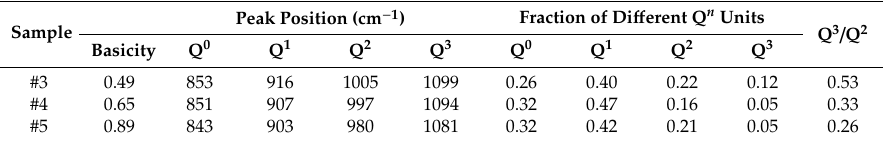
Table 4. FTIR peak shift and area fraction from FTIR spectra of FCSM slags of di ff erent basicity. Sample